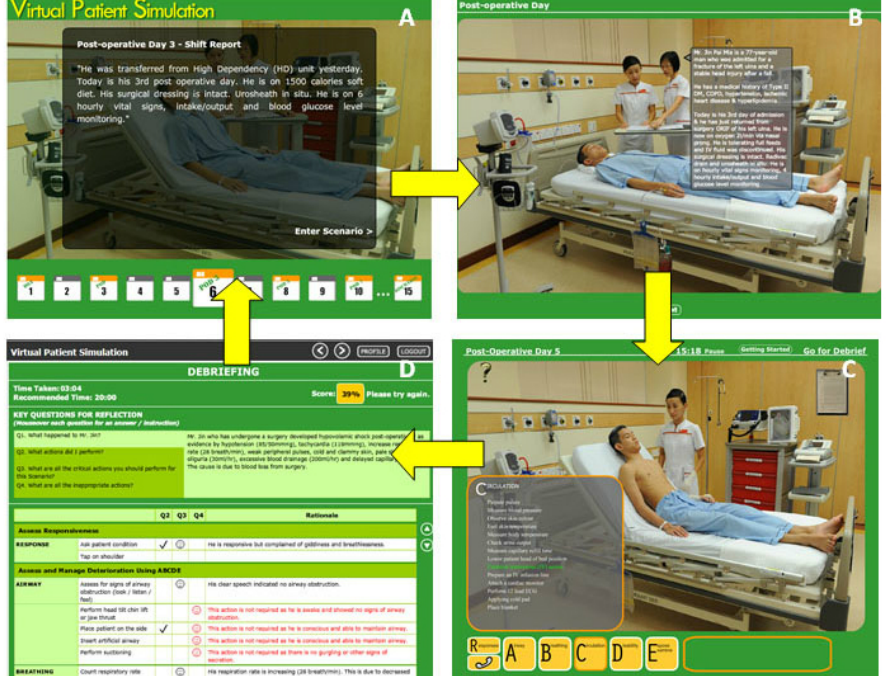
Figure 2. User follows A to D to navigate each scenario: A, Click on the patient’s day of admission to enter a scenario; B, Receive patient information during hand-off report; C, Emulate the role of nurse to assess and manage deteriorating patient by clicking on the ABCDE options menus; D, Self-reflection through a list of